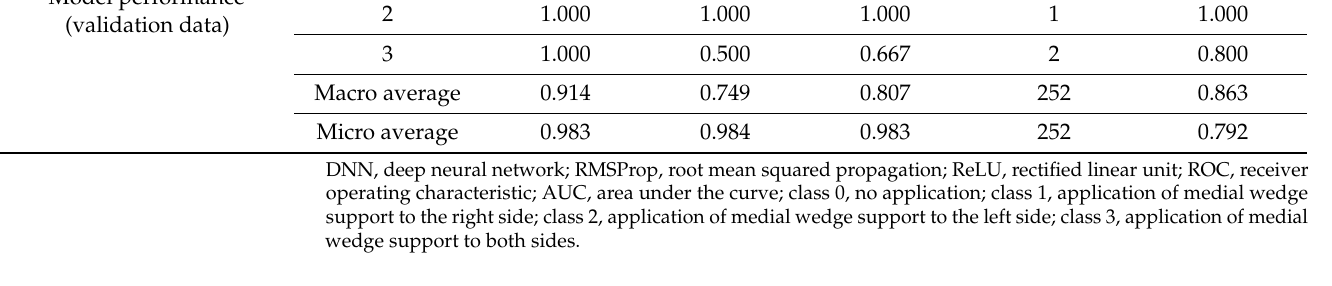
Table 5. Details of the model for determining the application of medial wedge